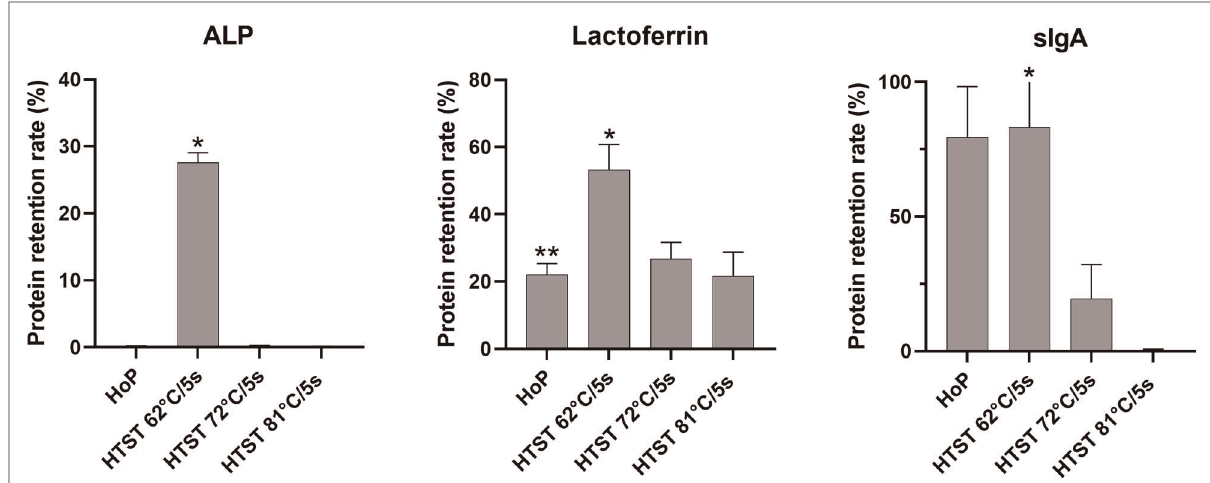
FIGURE 3 Protein retention rates after thermal treatment from 6 measurement of each parameter for each treatment. ALP, alkaline phosphatase; sIgA, secretory immunoglobulin A; HoP, Holder pasteurisation; HTST, high-temperature short-time treatment * p <0.001(HTST 62°C vs. HTST 72°C or HTST 81°C), ** p =0.31(HoP vs. HTST 72°C or HTST